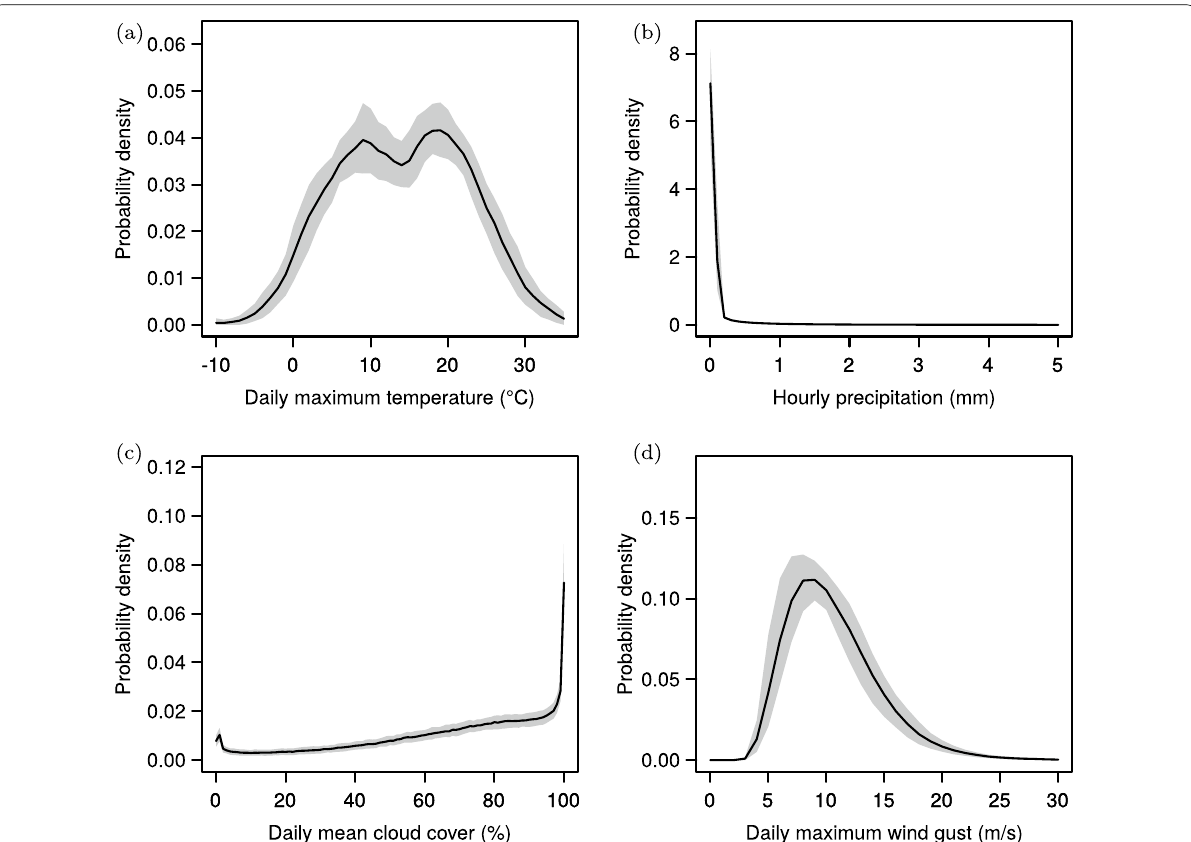
Fig. 1 Probability density functions of meteorological variables used in the models selection process. The thick black line indicates the average probability density at all traffic stations. The grey shaded area covers the range between the 0.1 and 0.9 quantile of probability densities at all traffic stations and indicates the variability between the different